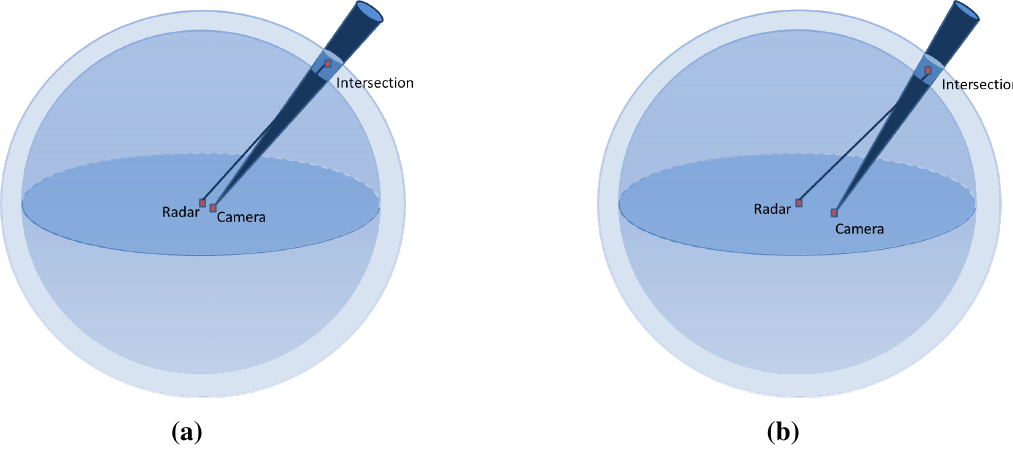
Figure 11. Illustration of the baseline effect on the reconstruction error. ( a ) Intersection uncertainty using a narrow baseline; ( b ) Intersection uncertainty using a wide baseline.